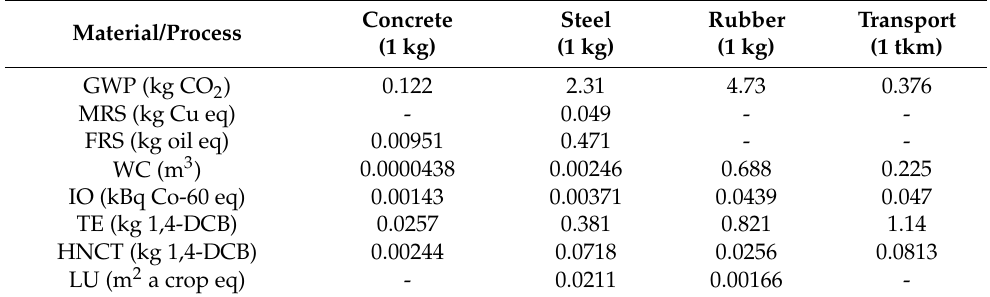
Table 6. Life-cycle impact assessment (LCIA) of Cases 1–3 (EcoInvent v3.2 database and ReCiPe2016 midpoint H